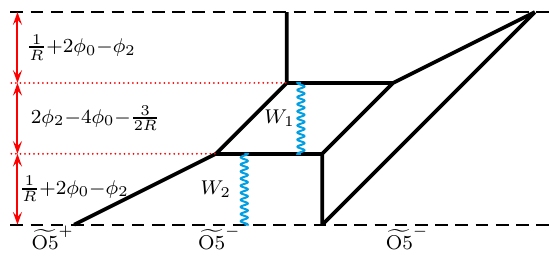
Figure 13. A 5-brane web for 6d SU(3) theory with Z 2 twist. The half monodromy cut extends from the right to the